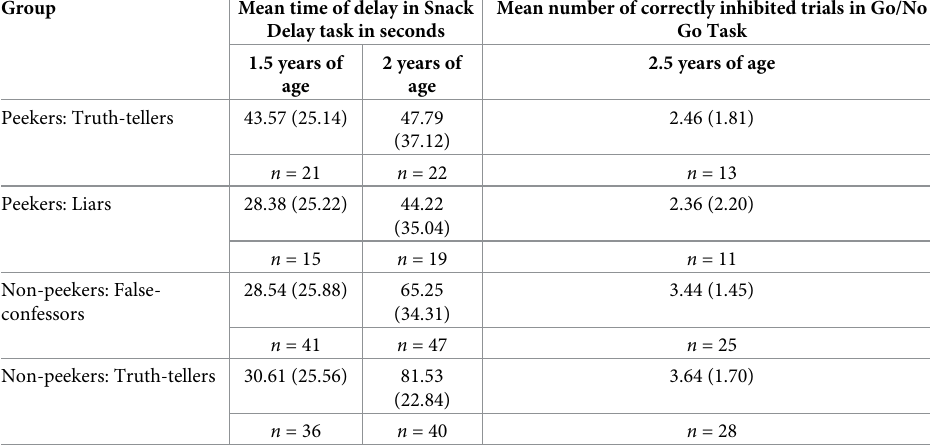
Table 4. Descriptive statistics of inhibitory control tasks ( SD in